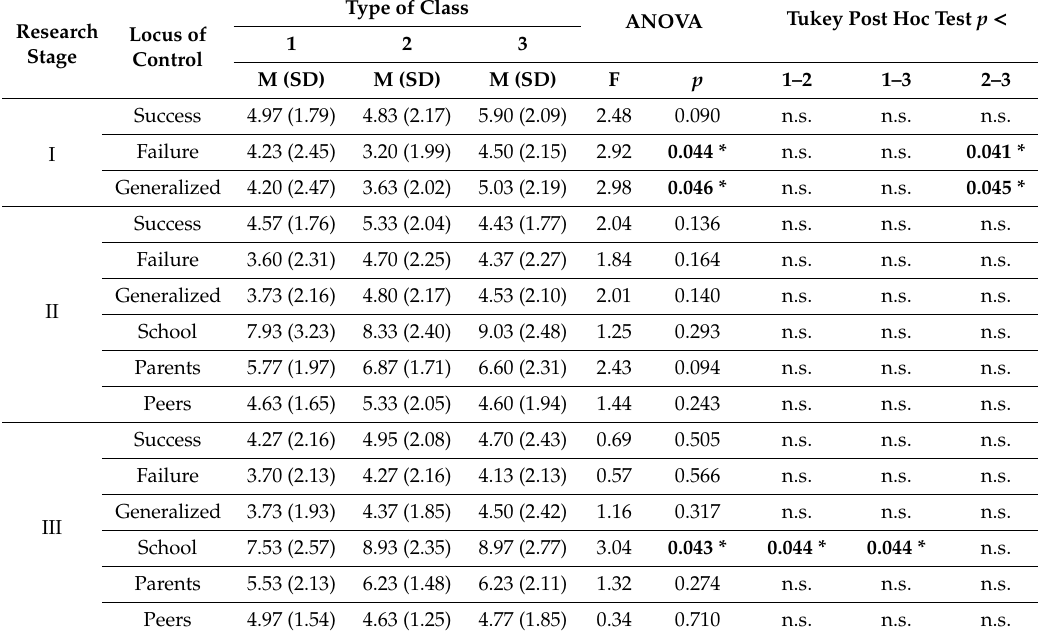
Table 1. One-way ANOVA of di ff erences between locus of control scores obtained by students from integrated and non-integrated classes during the three stages of the study: in the school years 2016 / 2017 (research stage I), 2017 / 2018 (research stage II), and 2018 / 2019 (research stage III). Type of Class Research Locus of Stage Control